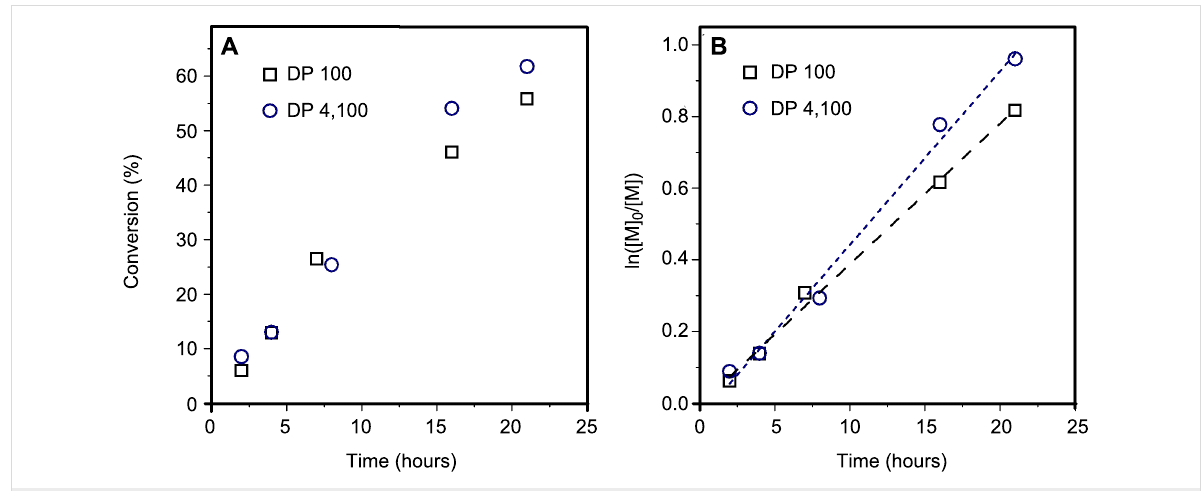
Figure 2: Conversion and ln([M] 0 /[M]) versus time for AIBN-initiated, PABTC-mediated polymerization of VBC at DP 100 (squares) and DP 4,100 (circles): (A) monomer conversion versus reaction time; (B) semilog kinetics plots with dashed lines indicating linear fits of the data (DP 100, long dashes; DP 4,100, short dashes).